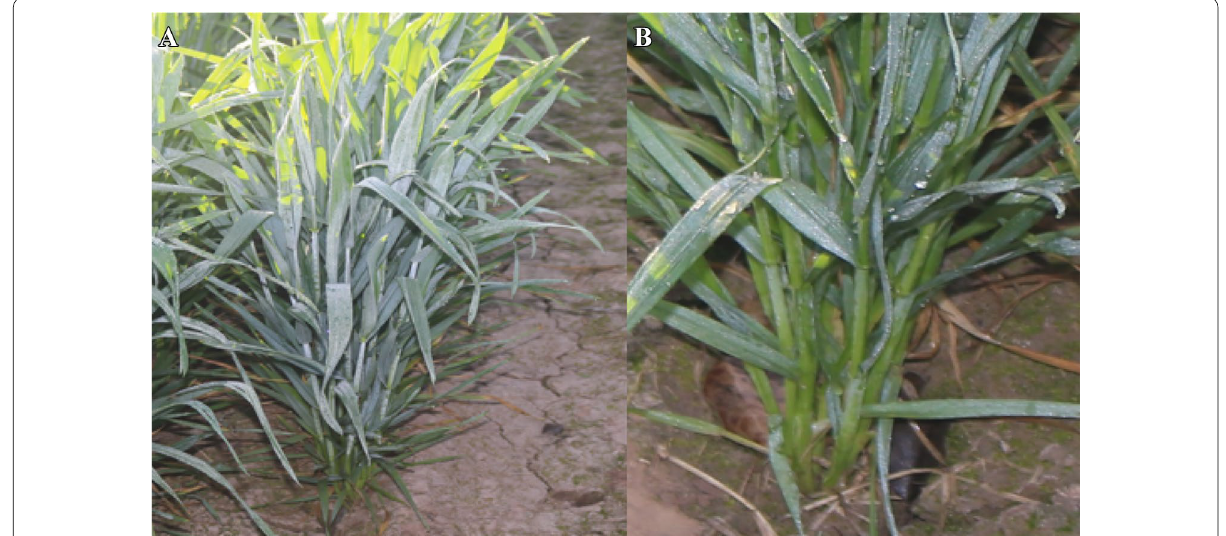
Fig. 1 Photographs of a wheat plant during fog events and b dampness due to fog water